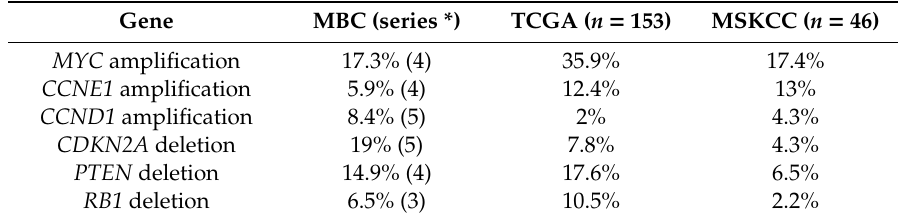
Table 2. Comparison of copy number variations (CNVs) of MBC compared with IDC series. Gene